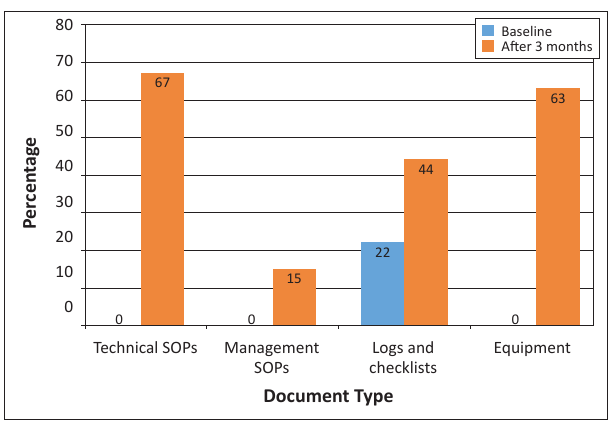
FIGURE 6: Improvement in documentation for Laboratory